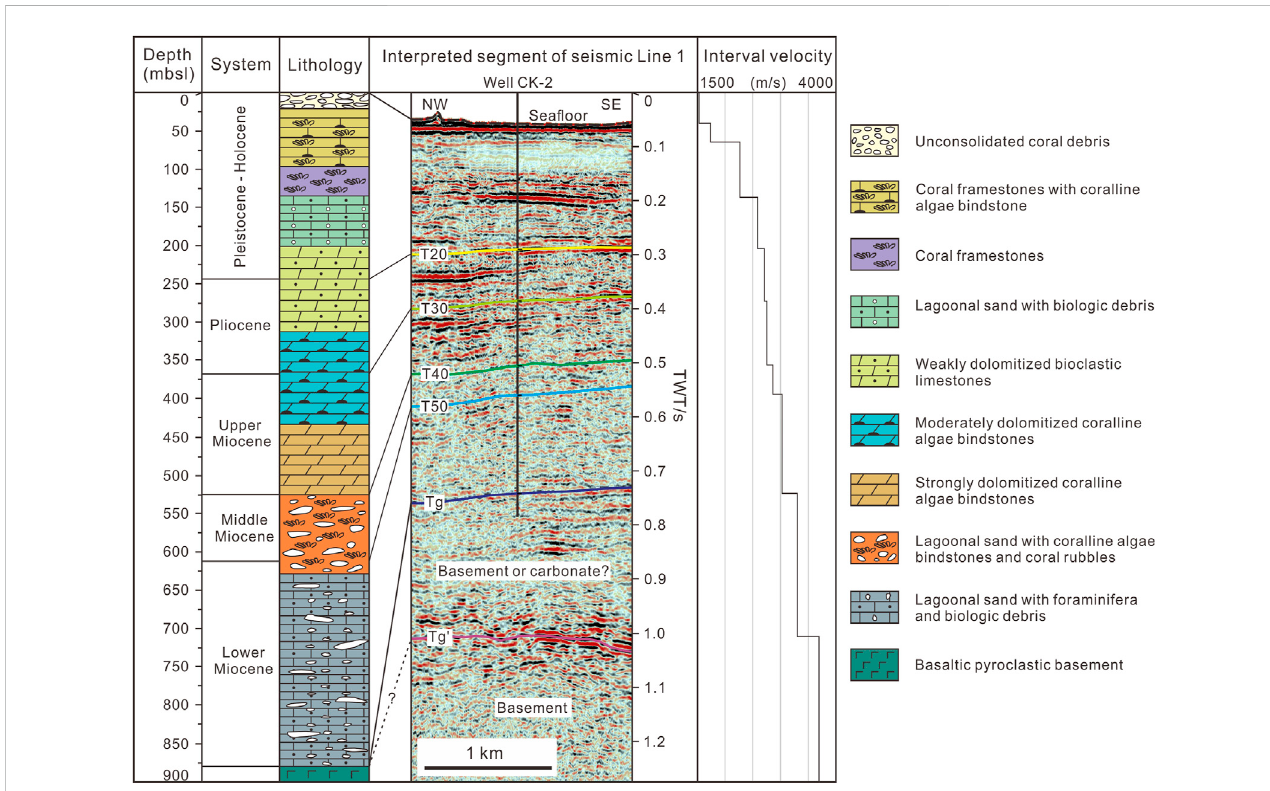
FIGURE 2 Stratigraphic column of well CK-2 (modi fi ed from Zhang et al., 2020; Fan et al., 2020), seismic pro fi le Line 1, and seismic interval velocity. Interpreted re fl ectors of sequences boundaries (T) are shown on seismic